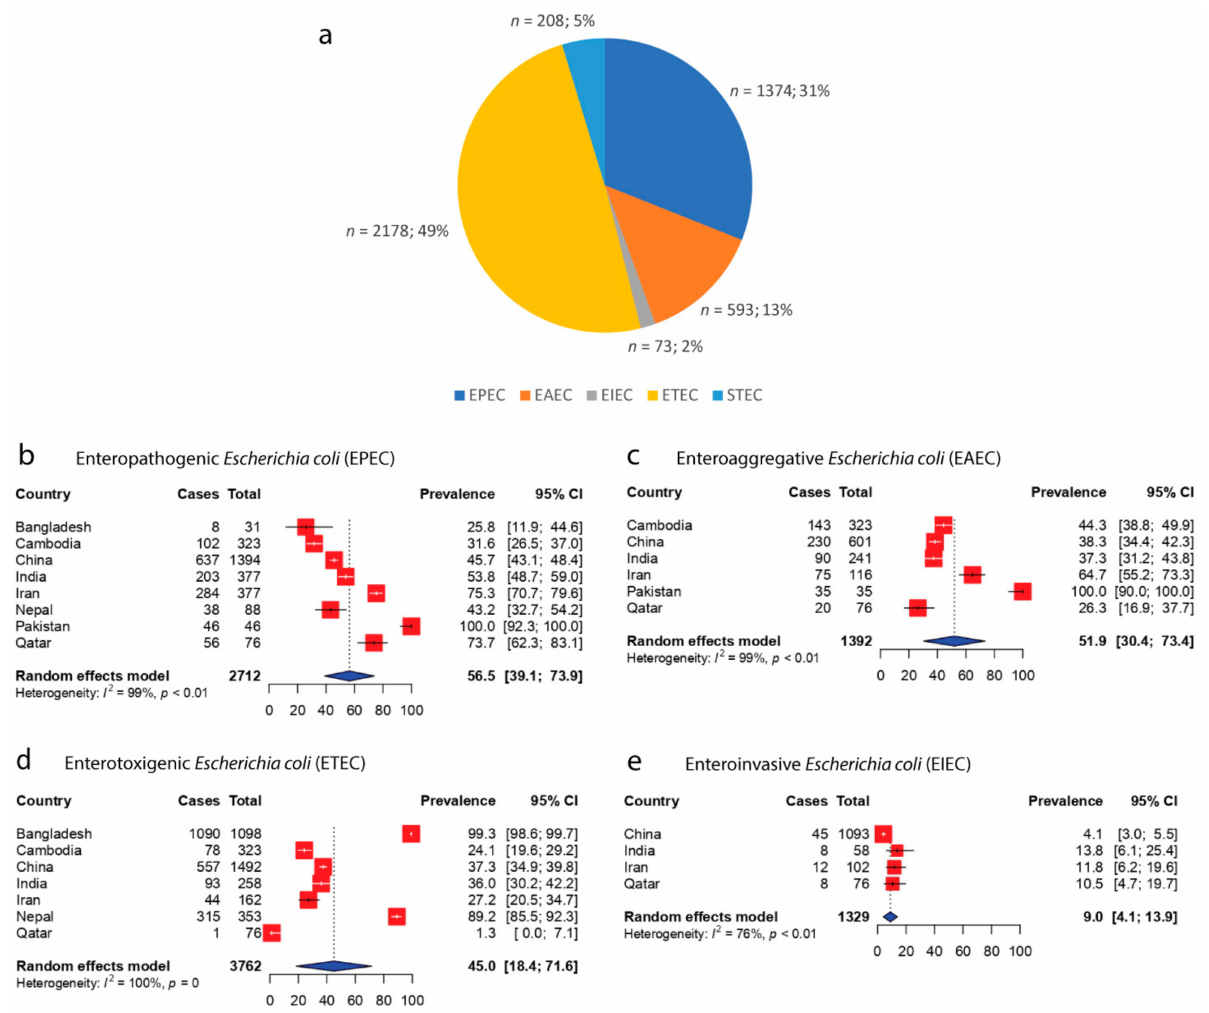
Figure 3. Pathotypes of DEC across Asian countries: ( a ) Proportions of different pathotypes of DEC. Enterotoxigenic E. coli constituted the highest proportion of DEC in Asia ( n = 2178; 49%), followed by EPEC ( n = 1374; 31%), EAEC ( n = 593; 13%), STEC ( n = 208; 5%), and EIEC ( n = 73; 2%). ( b ) Forest plot representing the pooled Asian prevalence of enteropathogenic E. coli (EPEC). ( c ) Forest plot representing the pooled Asian prevalence of enteroaggregative E. coli (EAEC). ( d ) Forest plot representing the pooled Asian prevalence of enterotoxigenic E. coli (ETEC). ( e ) Forest plot representing the pooled Asian prevalence of enteroinvasive E. coli